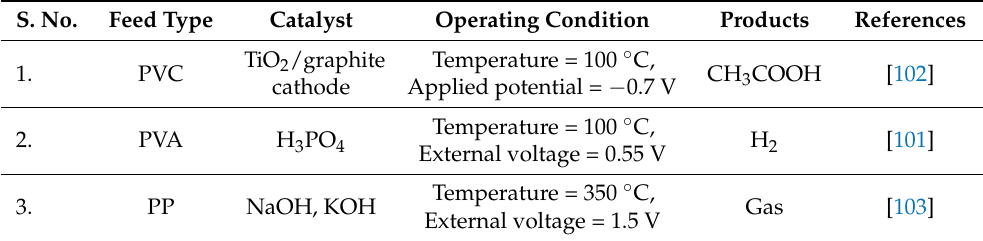
Table 8. Summary of studies on electrocatalytic